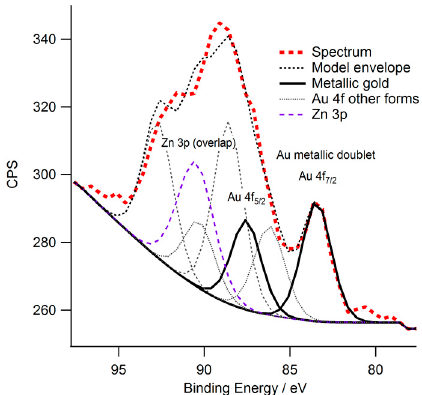
Figure 9. An X-ray photoelectron spectroscopy spectrum determined for a partially completed three dimensional build of Formulation 5. The peak at 83.6 +/ − 0.2 eV was identified as signaling the presence gold nanoparticles proximal to the exposed surface. The remainder of the peaks are associated with gold in other, unreduced, states and with Zn from the surrounding substrate glass.